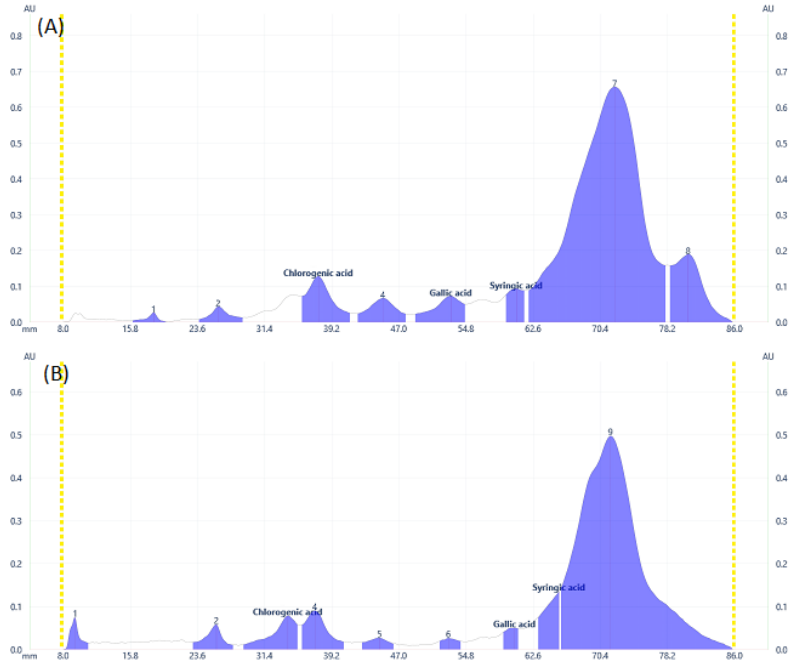
Molecules 2023 , 28 , x FOR PEER REVIEW Figure 2. Phenolic acids profile at 273 nm for (A ) DAL, ( B ) DAF samples. Figure 2. Phenolic acids profile at 273 nm for (A ) DAL, ( B ) DAF samples. From the methanol extract of D. angustifolia leaves, out of eight components, three phenolic acids were identified (Figure 2) and 14 components were detected, among which three flavonoids were identified (Figure 3).